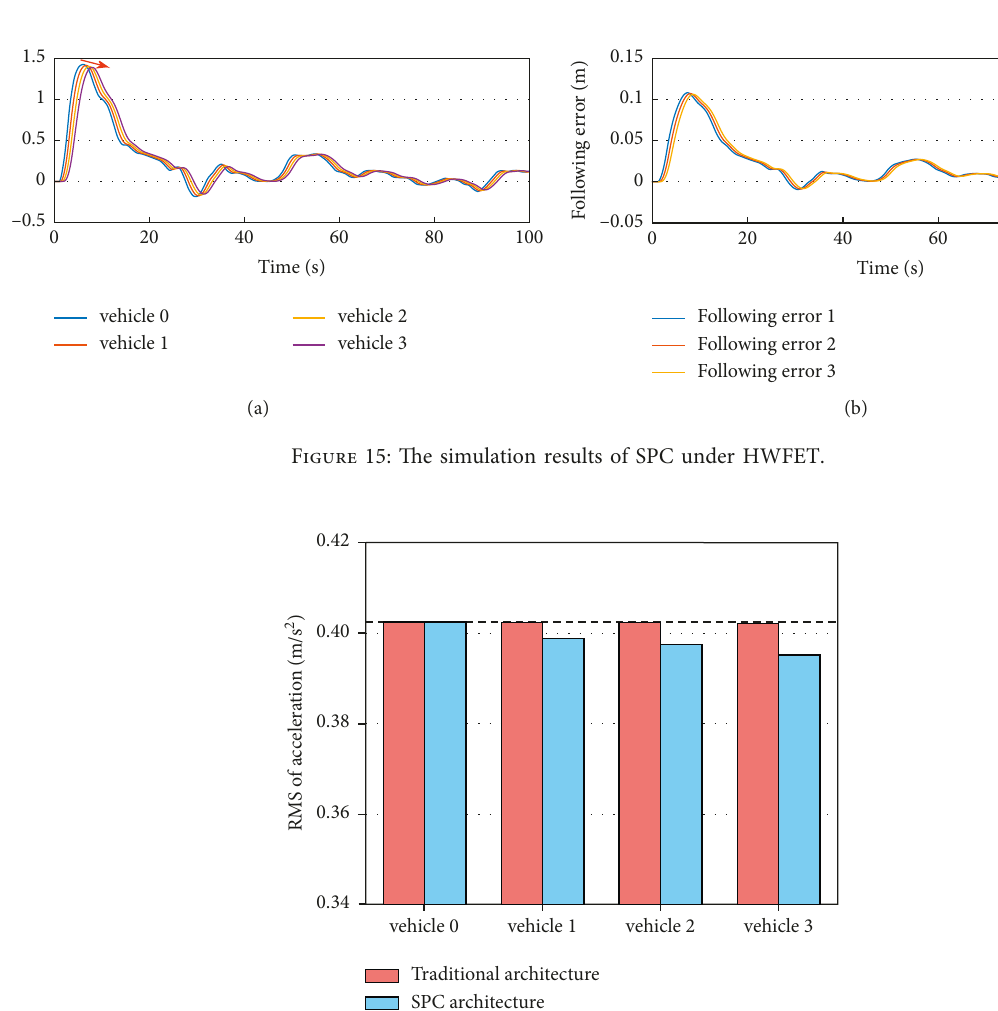
Figure 16: The comparison of acceleration root mean square values in two different